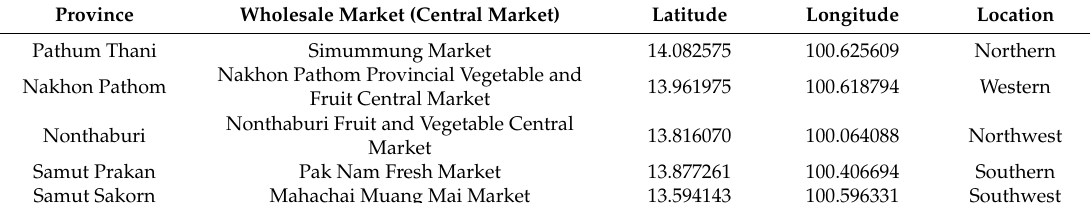
Table 3. Wholesale market of six provinces around Bangkok area.